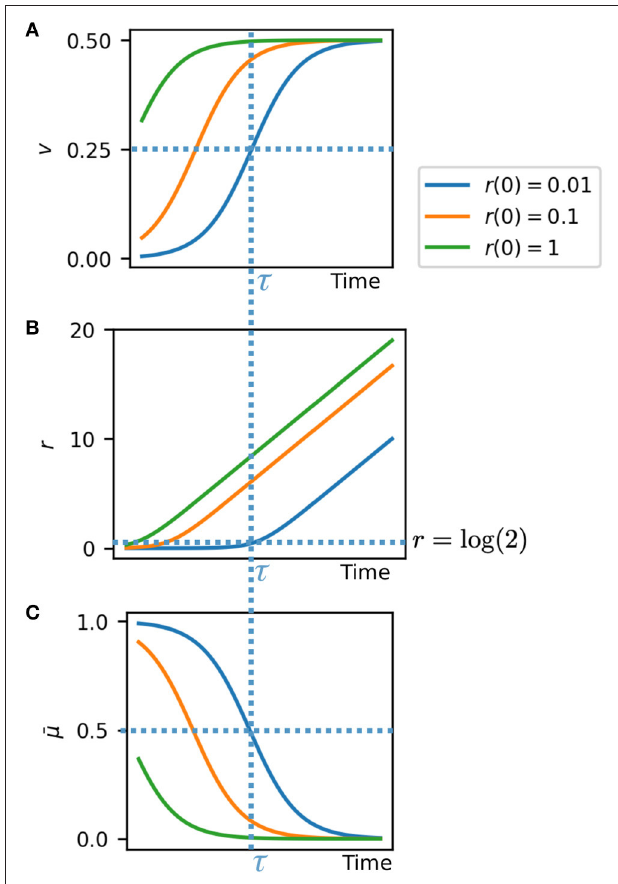
FIGURE 3 | Analytical solutions for cell velocity (A) and position (B) relative to the colony edge, and growth rate (C) , based on exponential decay of growth rate with distance from colony edge. At critical time τ the system switches between two regimes: high growth/low velocity, and low growth/high